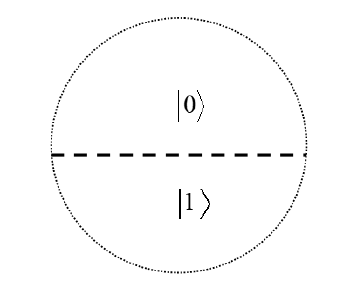
Figure 4. N = 2 fuzzy sphere.